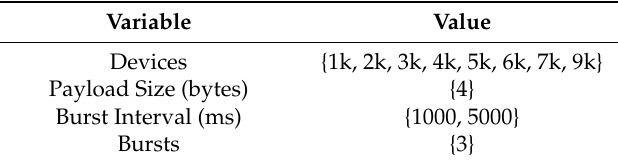
Table 3. Experiment 1 description setting.